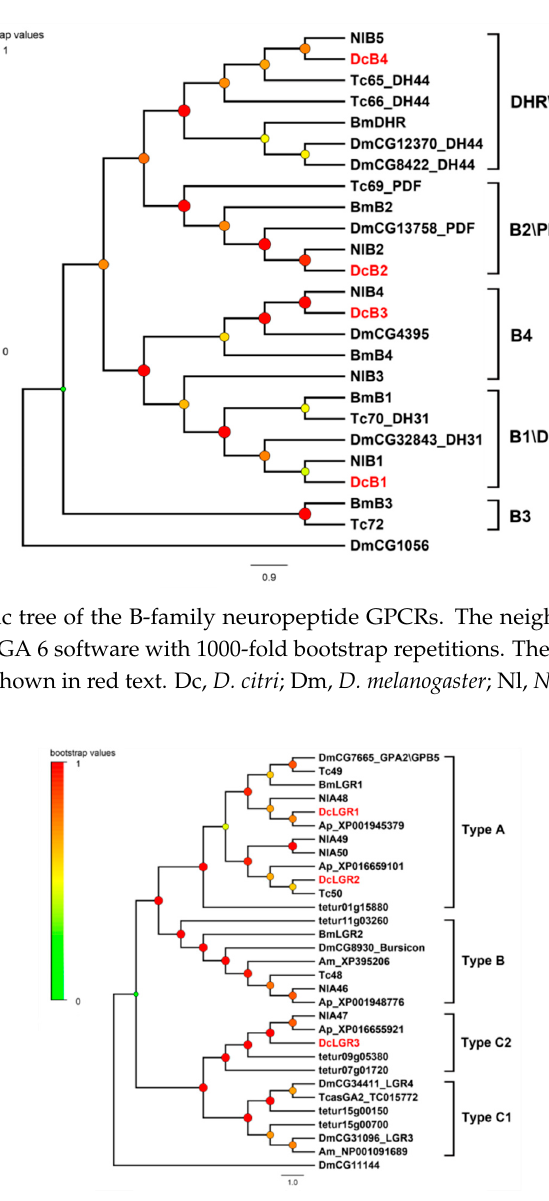
Figure 2. Phylogenetic tree of the A-family neuropeptide GPCRs. The neighbor-joining trees were constructed using MEGA 6 software with 1000-fold bootstrap repetitions. The A-family neuropeptide GPCRs of D. citri are shown in red text. Dc, D. citri ; Dm, D. melanogaster ; Nl, N. lugens .